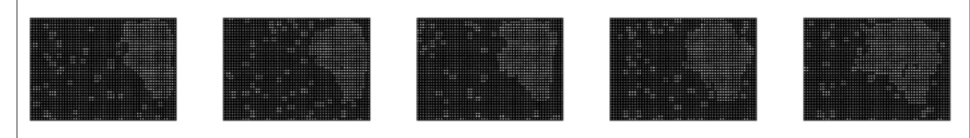
Figure 4. Visual Representation of HOG Descriptor Commuted for DGF.